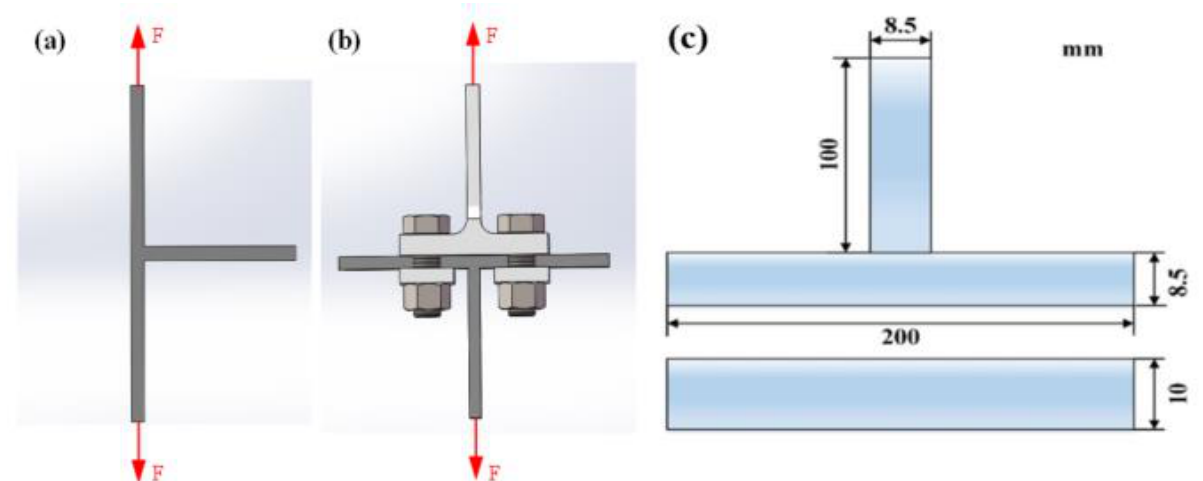
Figure 3. Illustration of the hardness test of SSFSW T-joint.